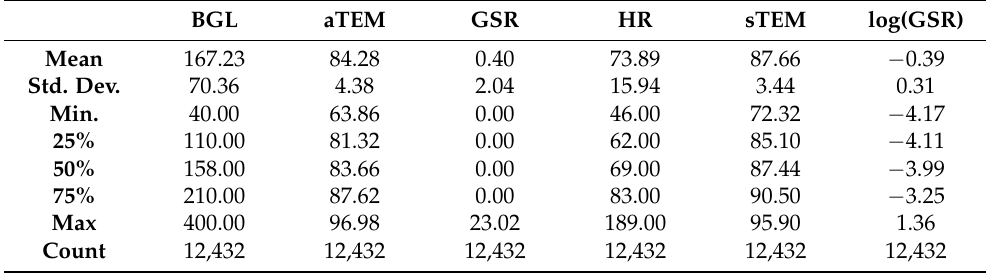
Table 1. Statistical analysis of Subject 559 from the OhioT1DM dataset. BGL—blood glucose level in mg/dL; aTEM—ambient temperature in ◦ F; GSR—galvanic skin response; HR—hear rate in bpm; sTEM—skin temperature in ◦ F; log(GSR)—logarithm with base 10 of the galvanic skin